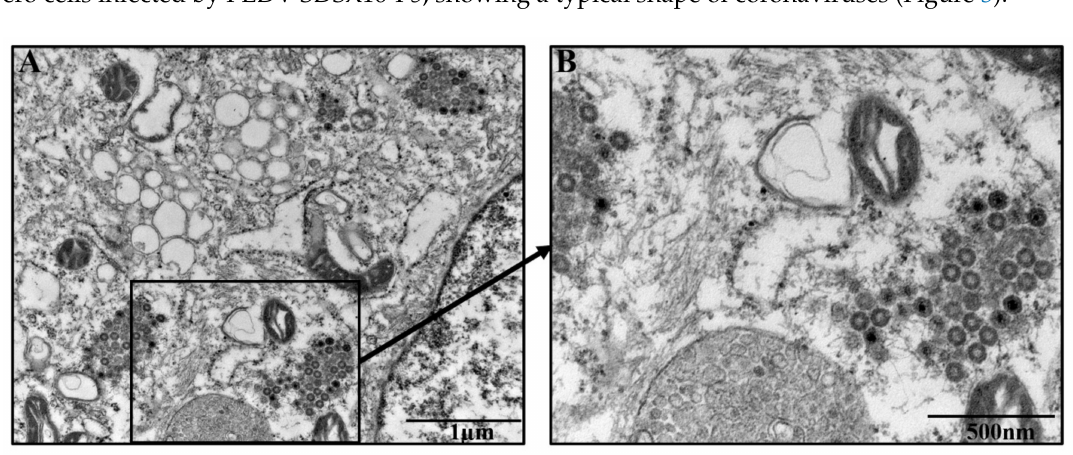
Figure 3. Electron micrographs of PEDV SDSX16-P5-infected Vero cells. ( A ) Virus-particles were found in the cytoplasm of Vero cells. ( B ) Enlarged view of the boxed area in ( A ). Black arrow indicates the presence of PEDV particles. Bars represent 1 µ m ( A ), and 500 nm ( B ),